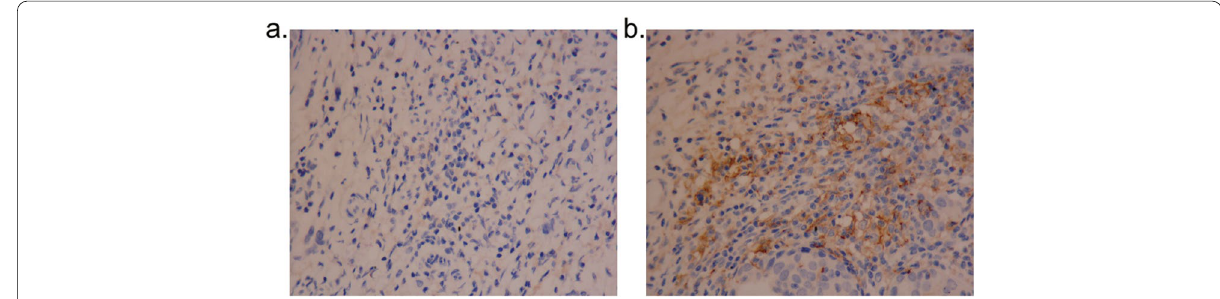
Fig. 2 The high and the low level of PD-L1 positive immune cells in TME, A Patients with low level of PD-L1 positive immune cells in TME